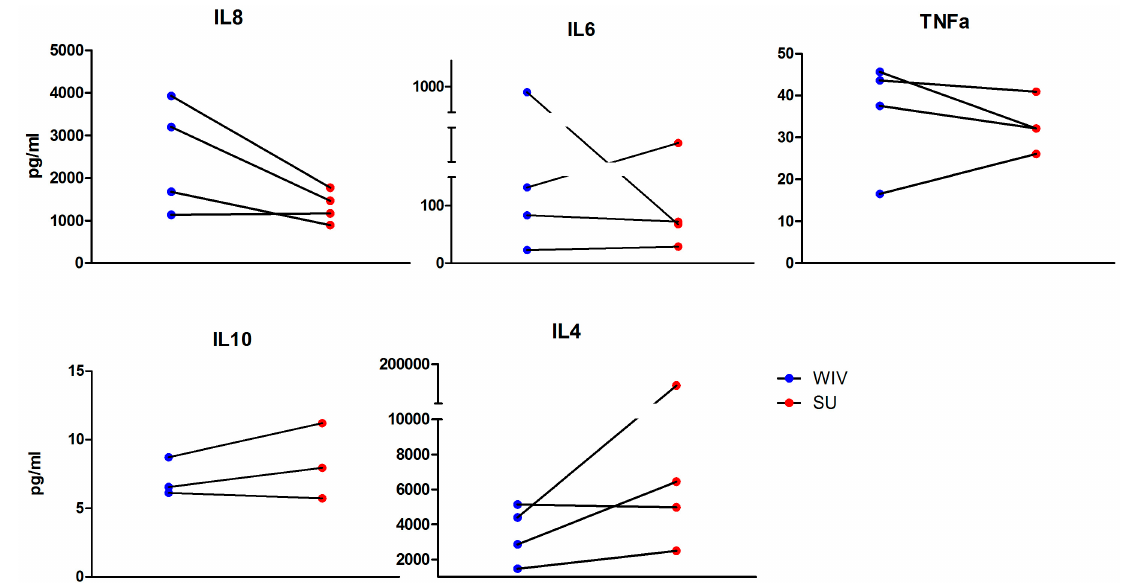
Figure 4. Stimulation of Mo-DCs with WIV elicits a higher production of cytokines than stimulation with SU. Supernatants from WIV, SU and mock-stimulated cells were collected 24 h after stimulation. Cytokines secreted were detected with a multiplex immunoassay using Luminex technology. Cytokine concentrations are given in pg/mL. Blue and red dots correspond to cells stimulated with WIV and SU, respectively. Dots connected with a line were obtained with cells from the same donor.